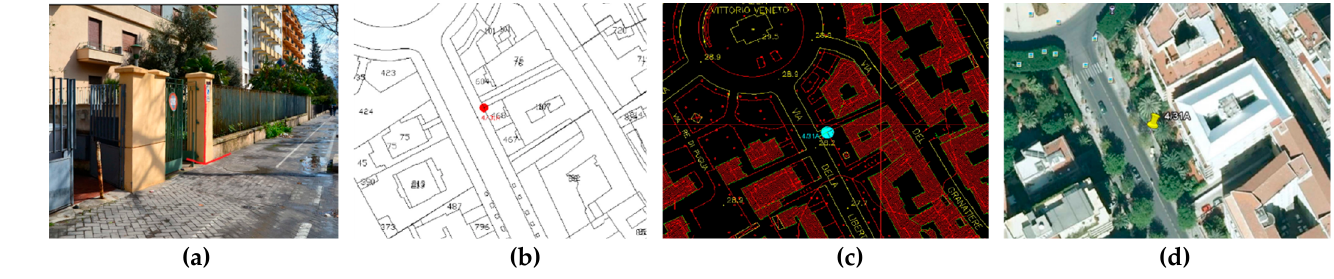
Figure 3. Example of coordinate determination: ( a ) fiducial marks image, ( b ) cadastral map, ( c ) numerical technical map, ( d ) Google Earth map.